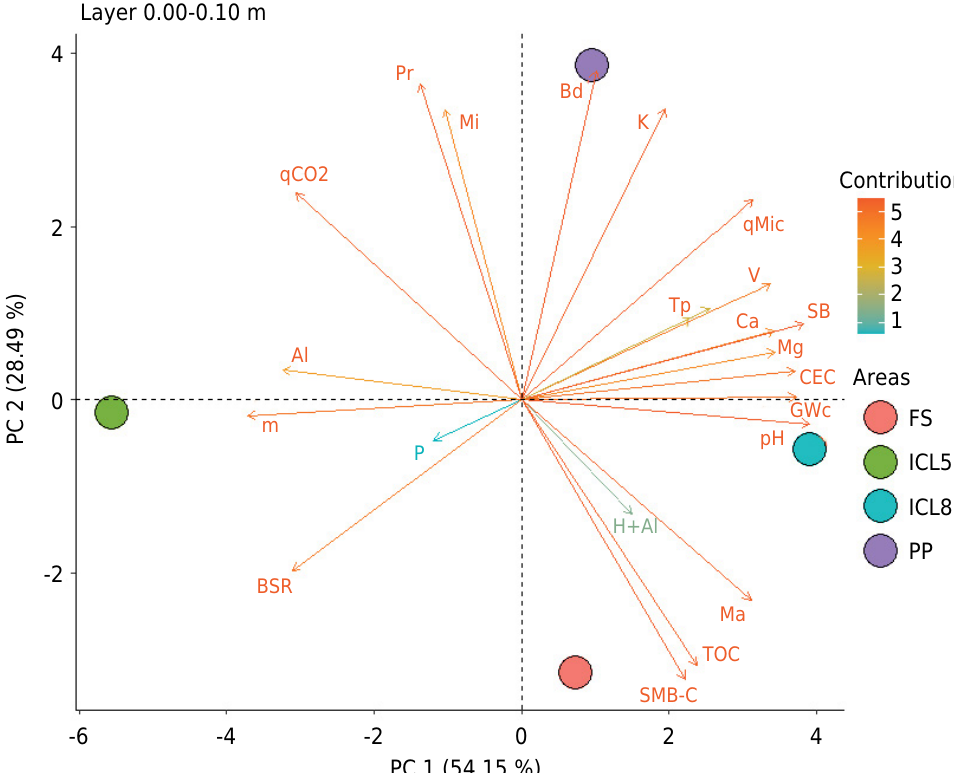
Figure 3. Biplot obtained by principal component analysis (PCA) in different areas in the Amazônia Maranhense and all variables in the 0.00-0.10 m soil layer. SF: Secondary Forest; PP: Perennial pasture; ICL5: Pasture recovered in integrated crop-livestock to five years; ICL8: Pasture recovered in integrated crop-livestock to eight